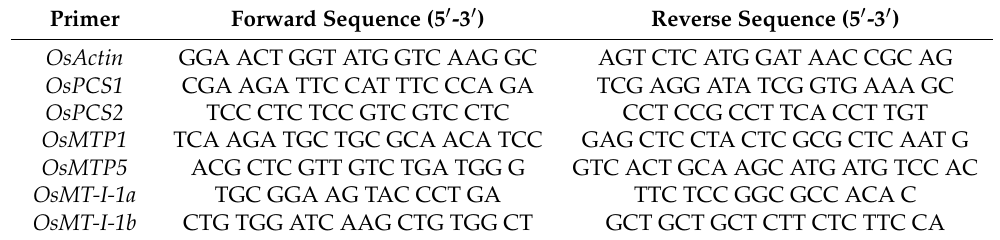
Table 2. List of primers used in this study.